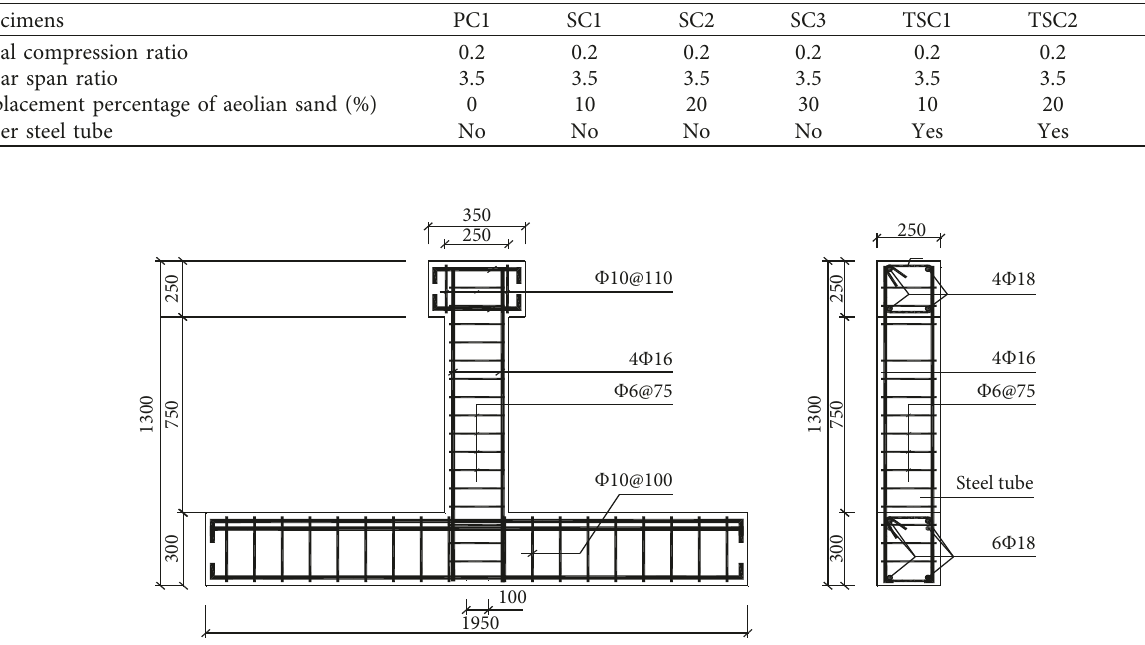
Table 1: Characteristics of the seven specimens.